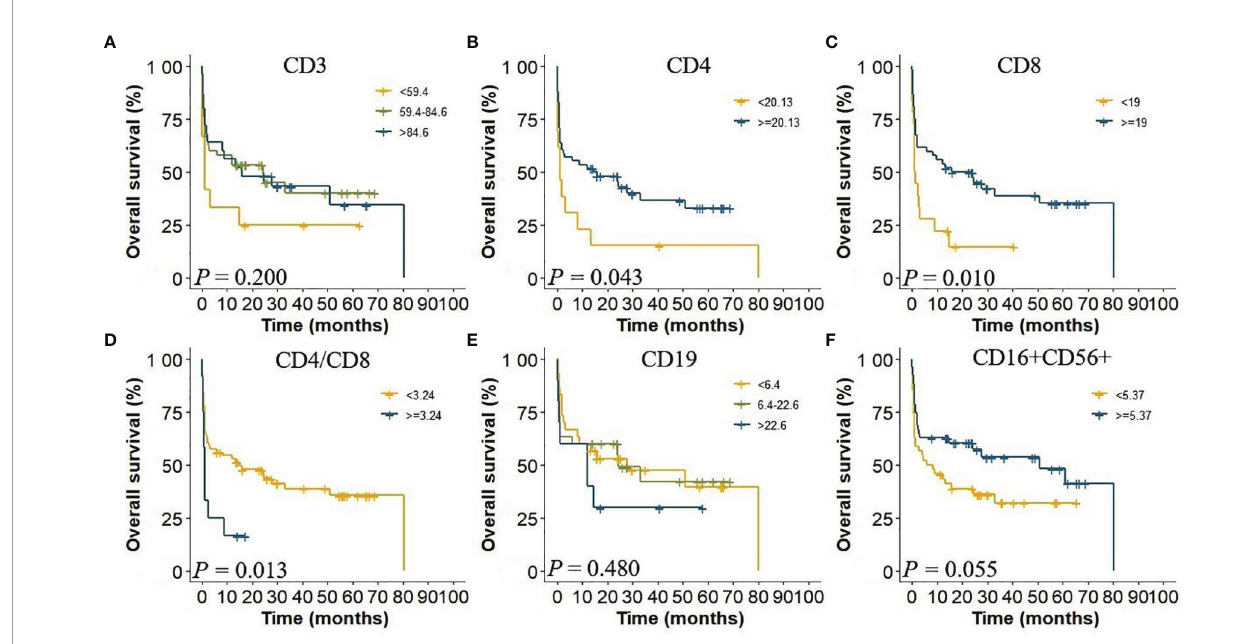
FIGURE 3 | Kaplan – Meier analysis of lymphocyte